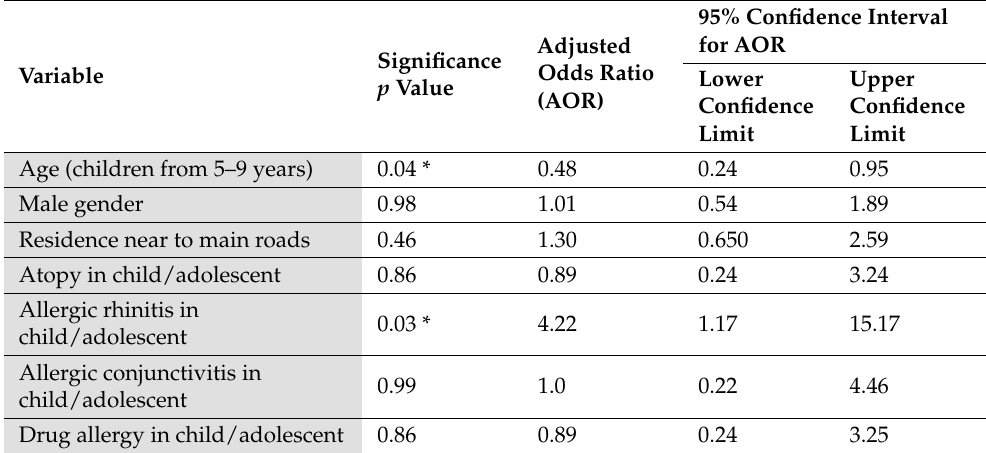
Table 3. Multivariate regression analysis for risk factors of any wheezing in children and adolescents in Rabigh